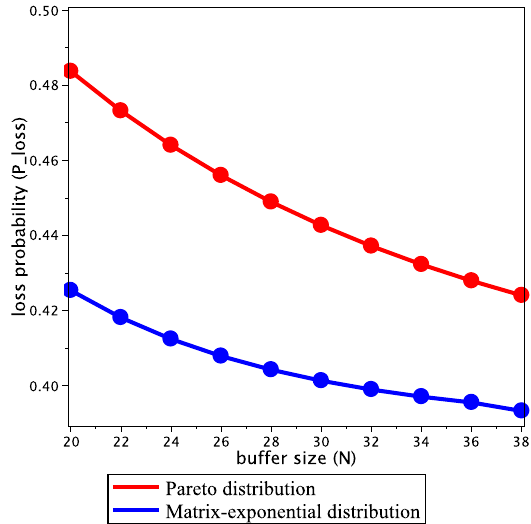
Figure 2. Effect of N on loss